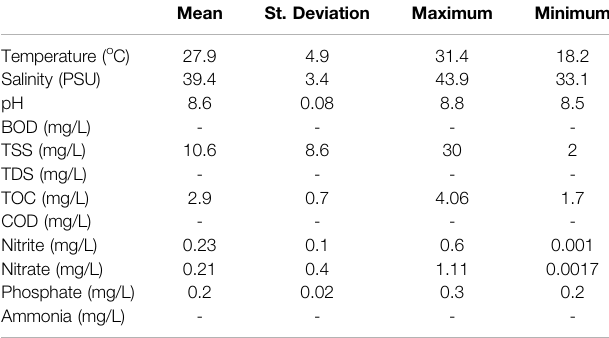
TABLE 5 | Statistical summary of water quality of the offshore locations D1 – D5. Mean St.